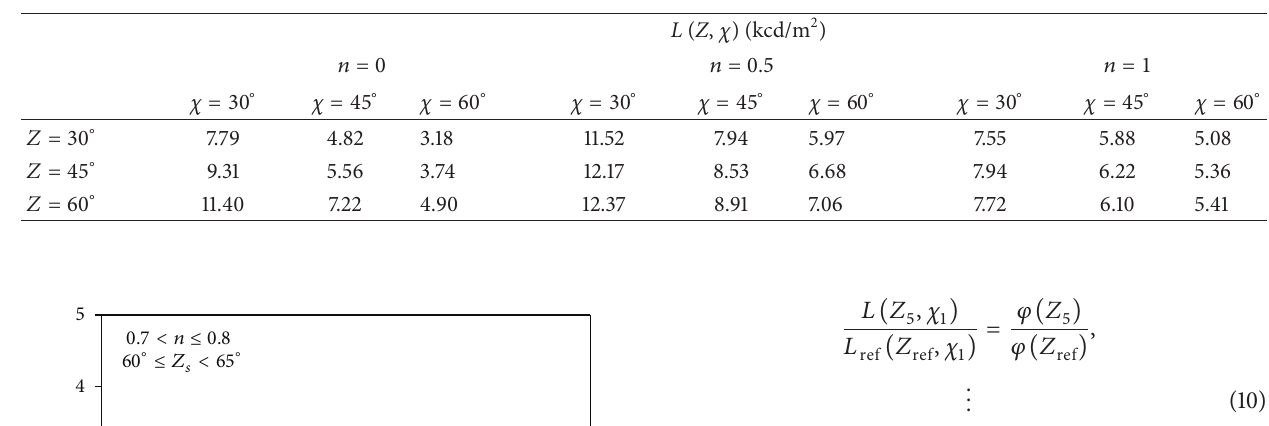
Table 2: Example of the absolute sky luminance ( L ) of some subzones indicated by zenith angle ( Z ) and indicatrix angle (𝜒) for solar zenith angle (𝑍 𝑠 ) of 55 ∘ –60 ∘ with different values of cloud index ( n ).